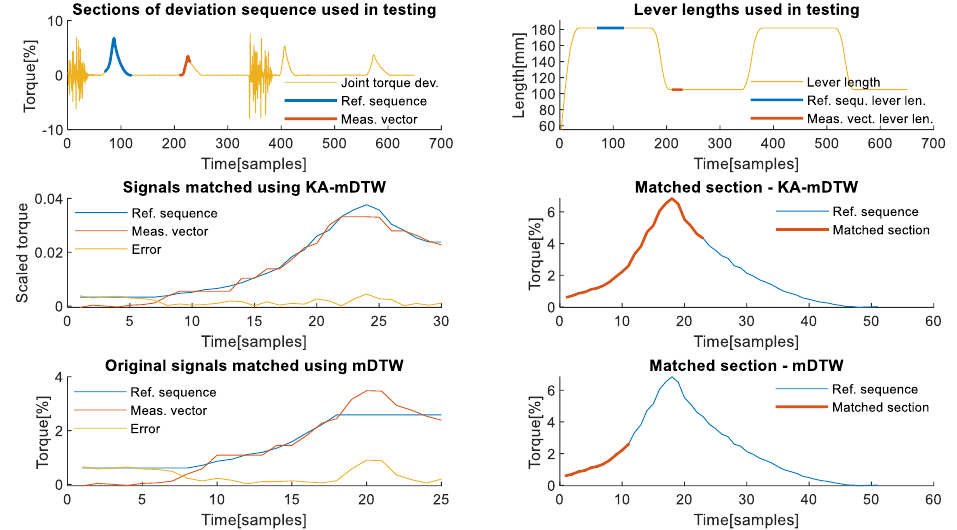
Figure 10. Matching chosen signals from the 3rd axis. ( Upper left ) Section of the deviation signal used as a reference sequence during analysis, and the section used as the measurement vector. ( Upper right ) Sections of the lever lengths corresponding to the chosen reference sequence and the chosen measurement vector. ( Middle left ) Optimally matched section of the reference sequence, the entire measurement vector, and the sample-wise matching error. ( Middle right ) Reference sequence profile with the highlighted section, which was correctly recognized, optimally matched with the measurement vector. ( Lower left ) Section of reference sequence matched with measurement vector using mDTW without scaling the signals and matching error. ( Lower right ).